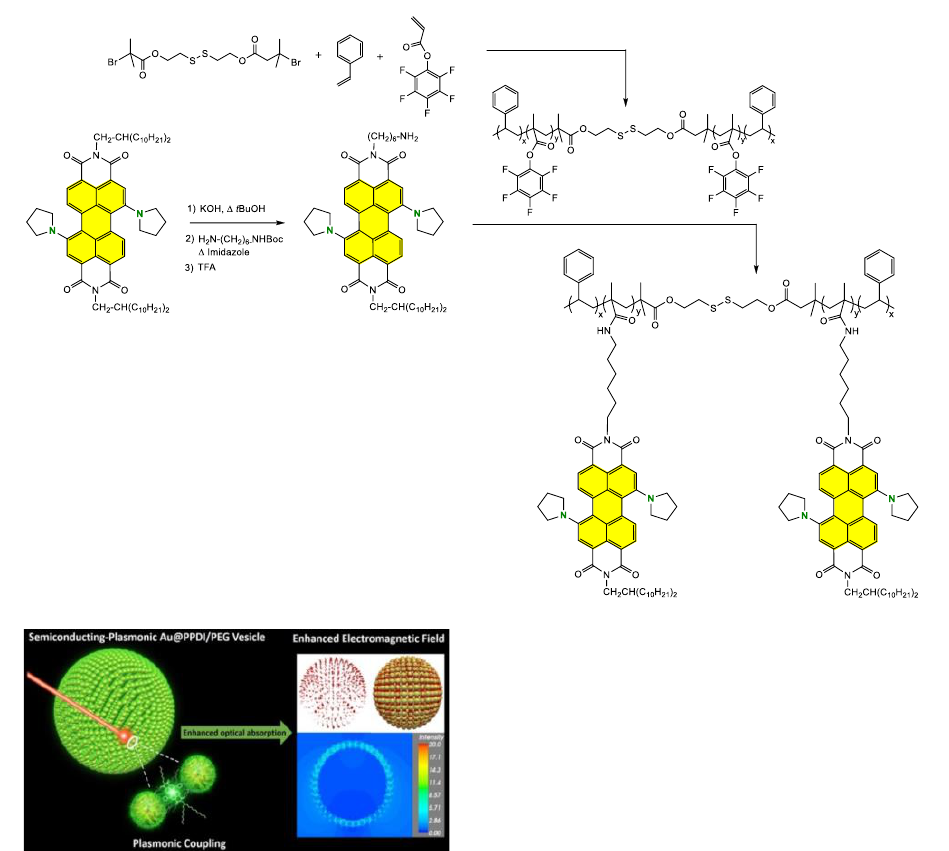
Figure 28. Synthetic scheme of polymer SS-PS-PPDI; illustration of the semiconducting-plasmonic vesicle of gold nanoparticle coated with PPDI and PEG. Reprinted with permission from reference [139]. Copyright 2017 Ivyspring.